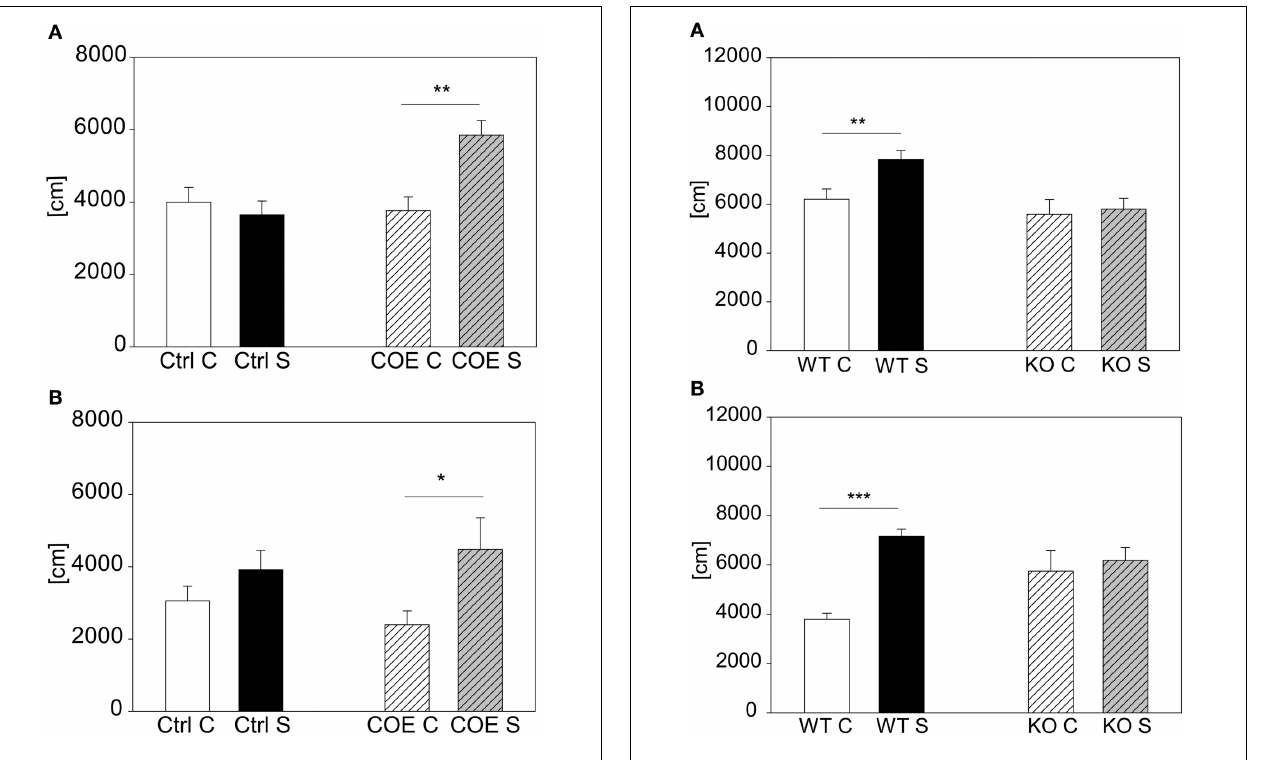
FIGURE 6 | CRH-COE CNS line. Graphs depict the distance traveled during FIGURE 7 | CRHR1-KO line. Graphs depict the distance traveled during the the first 5min in the OF. Both control (Ctrl) and CRH over-expressing (COE) first 5min in the OF. For the animals from the more stress-resistant line, the littermates of the more stress-reactive CRH-COE CNS line were exposed to CRHR1-KO line, the 15min restraint stress period only had an effect in the a 15min restraint stress period. At the second exposure there was a wildtypes (WT) (A) . This effect of reduced responsivity to stress in mutants significant interaction between genotype and stress effect. Control (KO) was even clearer in a second cohort of animals with a 2h exposure to littermates did not respond to the stress with increased activity, whereas restraint (B) . Wildtypes showed an increased responsivity, whereas the the CRH over-expressing mice did (A) . The second cohort confirmed the stressed mutants did not show any difference compared to their result of higher stress-responsivity in the CRH over-expressing mice (B) . unstressed controls. Control groups, C, in white or white striped and stress Unstressed groups, C, in white or white striped and stress groups, S, in groups, S, in black or gray striped bars. Error-bars shown as s.e.m.; black or gray striped bars. Error-bars shown as s.e.m.; Significances: Significances: ∗∗ p ≤ 0 . 01; ∗∗∗ p ≤ 0 . 001; n = 7–13 per group in the first ∗∗ p ≤ 0 . 01; ∗ p ≤ 0 . 05; n = 7–11 per group; n = 5–9 per cohort; n = 4–6 in the second (cohort1) (cohort2) group.